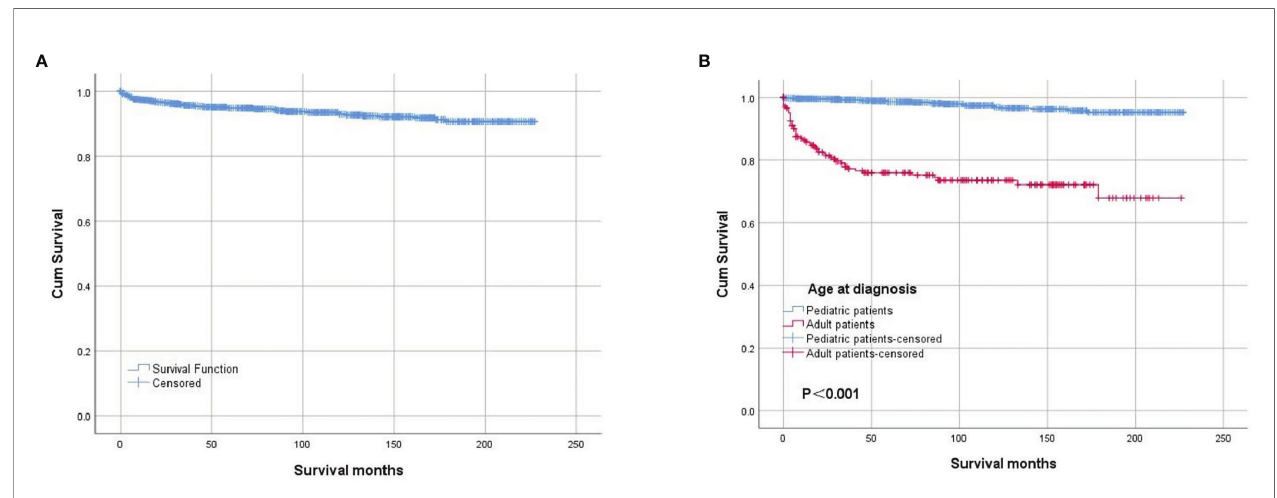
FIGURE 2 | Kaplan – Meier survival analysis: (A) The overall survival for the whole cohort. The survival analysis of patients classi fi ed based on age at diagnosis (B) .